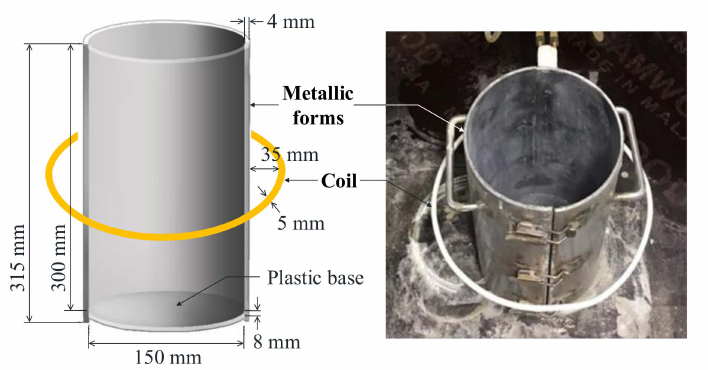
Figure 2. Details of metallic forms with a coil for finite element method (FEM)